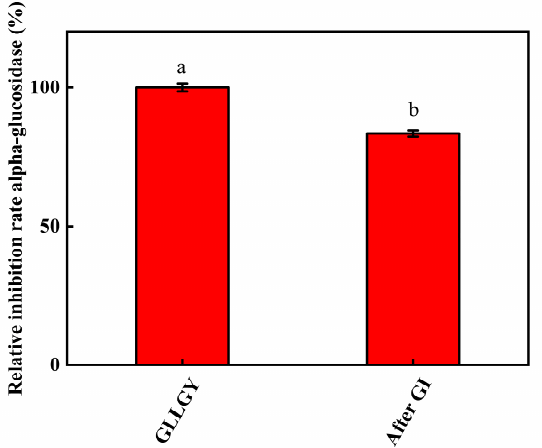
Figure 6. GLLGY α -glucosidase inhibition activity in a simulated gastrointestinal digestion sys- tem.